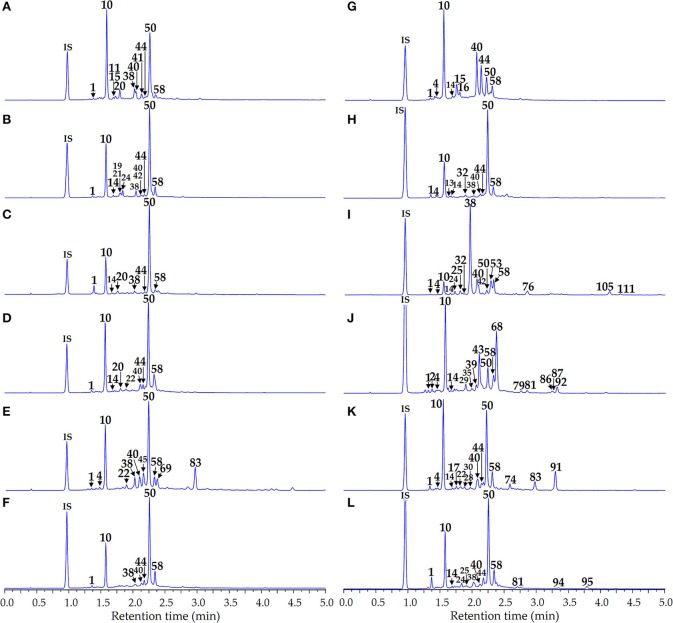
HPLC-DAD chromatograms of the total extracts of Artemisia species at 280 nm. (A)
A. anethifolia; (B)
A. commutata; (C)
A. desertorum; (D)
A. integrifolia; (E)
A. latifolia; (F)
A. leucophylla; (G)
A. macrocephala; (H)
A. messerschmidtiana; (I)
A. palustris; (J)
A. sericea; (K)
A. tanacetifolia; (L)
A. umbrosa. Compounds are numbered as listed in Table 2. IS, internal standard (scopoletin-7-O-neohesperidoside).